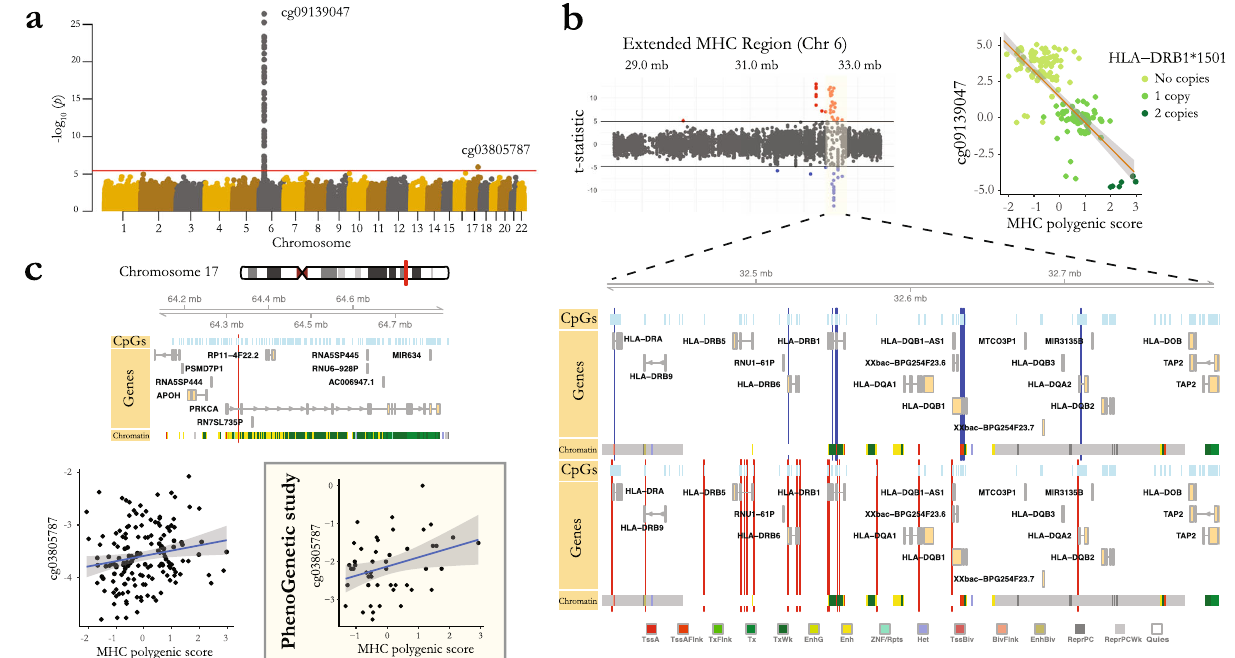
Fig. 4 cis and trans DNA methylation effects of MS MHC polygenic score. a Manhattan plot shows association p -values between CpG methylation levels and MS-associated MHC polygenic score. Red horizontal line shows the signi fi cance threshold (FDR < 5%). Top CpGs in the two signi fi cant regions are speci fi ed. b t -statistics for positive and negative associations between the methylation levels of the CpGs located inside the extended MHC region and the MHC polygenic score are shown (red: positive, blue: negative). The inset illustrates the genomic location of the signi fi cant CpGs in the MHC class II region in relation to nearby CpGs, genes, and modeled chromatin states. Blue/red vertical lines represent the locations for CpGs with negative/positive associations with the MHC polygenic score, respectively. Association between the top identi fi ed CpG, cg09139047 located in the HLA-DRB1 gene, and MHC polygenic score (shown in Z -scores) is visualized in the top right corner. Colors represent the number of HLA-DRB1*1501 alleles. c The genomic location for cg03805787 (associated with the MHC polygenic score in chromosome 17, red vertical line) is shown in relation to surrounding CpGs, genes, and modeled chromatin states. Bottom panel illustrates the association between cg03805787 methylation levels (M-values) and MHC polygenic score ( Z - scores) in our main study of MS subjects, as well as the replication in the healthy subjects of the PhenoGenetic study. Error bands ( b , c ) represent 95% con fi dence interval. MHC = Major Histocompatibility